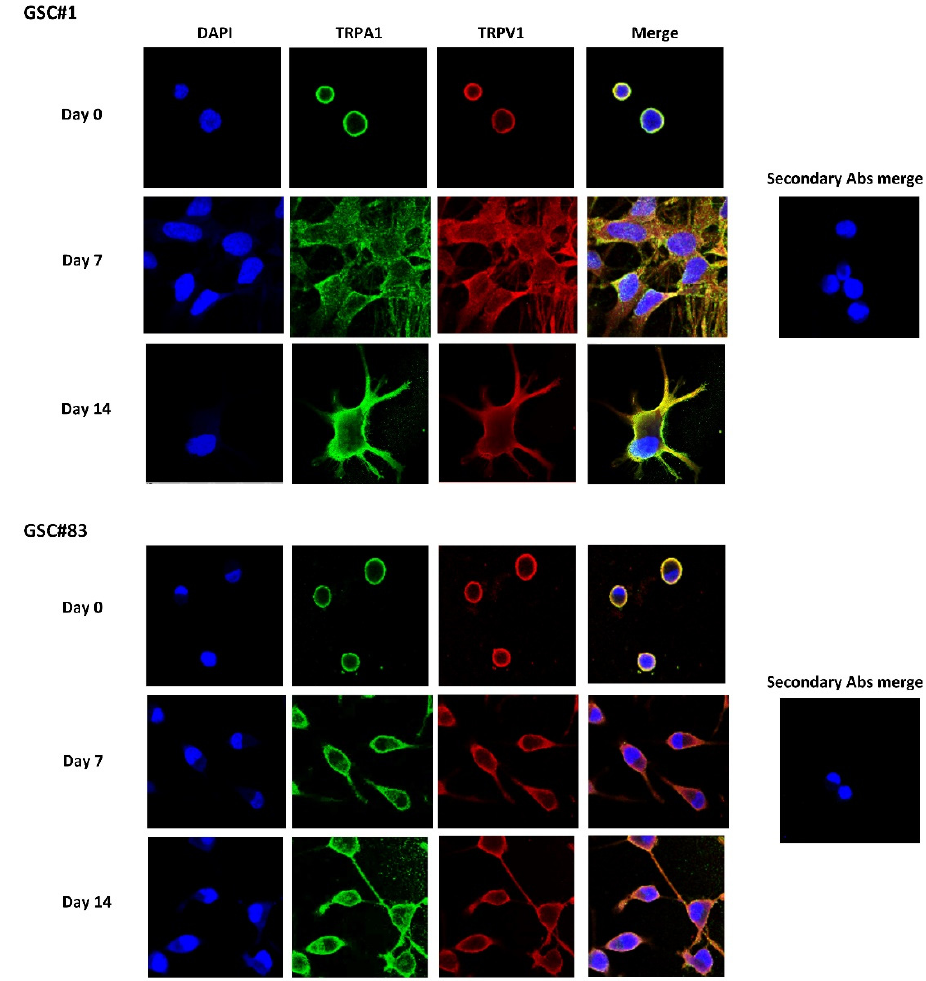
Figure 2. TRPs expression in GSCs during differentiation. GSCs (day 0) and D-GSCs (day 7 and 14) were fixed, permeabilized, and stained with anti-human TRPA1 and TRPV1 Abs followed by Alexa Fluor-488 and Alexa Fluor-594 secondary Abs, respectively. 40,6-diamidino-2-phenylindole (DAPI) was used to counterstain nuclei. Magnification 60×.